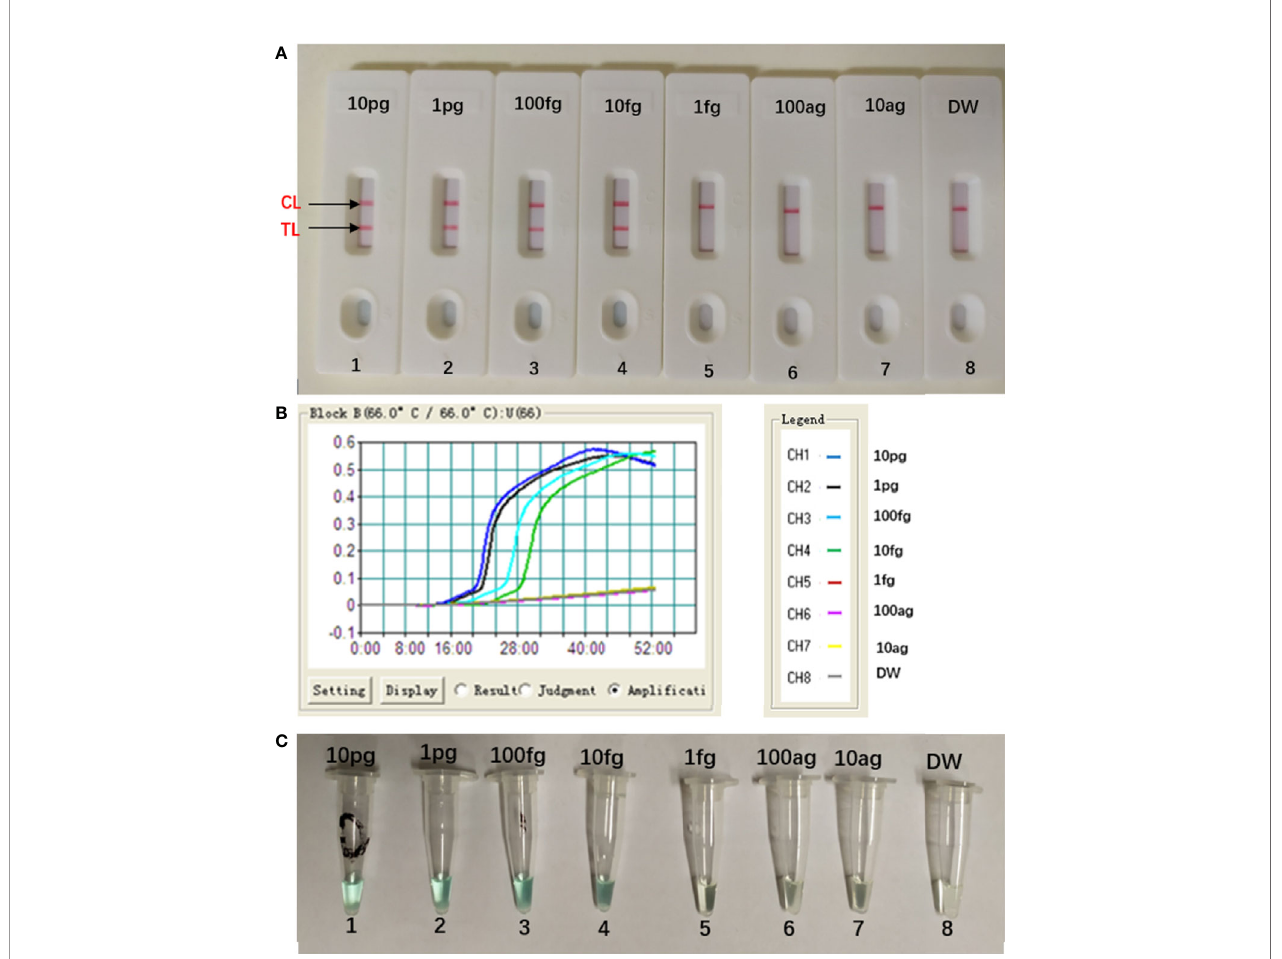
FIGURE 5 | Sensitivity of Aspergillus fumigatus -MCDA-LFB assay. Serially diluted genomic templates of Aspergillus fumigatus strain (ATCC96918) were used to detect the sensitivity of the MCDA-LFB assay. The LoD (limit of detection) was analyzed by LFB (A) and real time turbidity (B) , colorimetric indicator detection (C) . The serial dilutions (10 pg, 1 pg, 100 fg, 10 fg, 1 fg and 100 ag, 10 ag) of target templates were used for standard MCDA reactions. Biosensors (A) Turbidity signals (B) Tubes (C) 1 – 8 represented the DNA levels of 10 pg ( Aspergillus fumigatus ATCC96918 templates), 1 pg ( Aspergillus fumigatus ATCC96918 templates), 100 fg ( Aspergillus fumigatus ATCC96918 templates), 10 fg ( Aspergillus fumigatus ATCC96918 templates), 1 fg ( Aspergillus fumigatus ATCC96918 templates) and 100 ag ( Aspergillus fumigatus ATCC96918 templates), 10 ag ( Aspergillus fumigatus ATCC96918 templates) and blank control (DW). The genomic DNA levels of 10 pg to 10 fg per reaction produced the positive